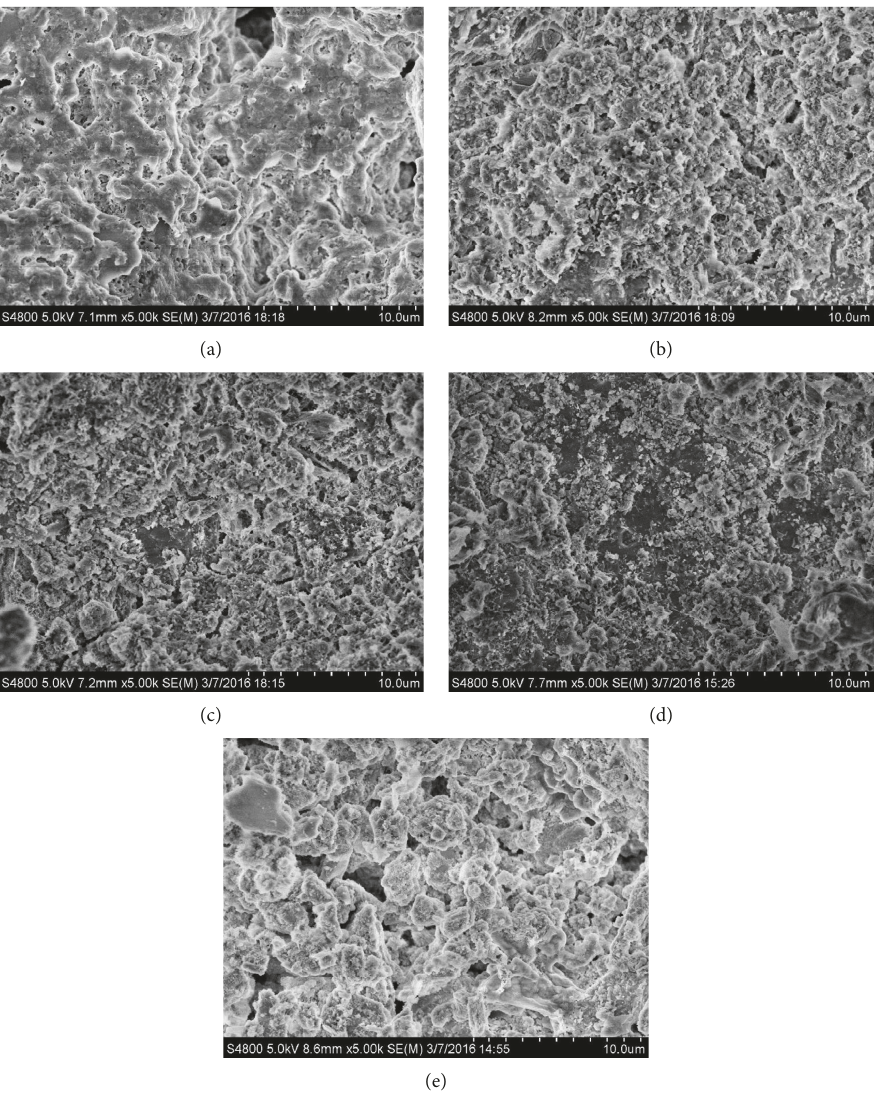
Figure 17: SEM of the solidified cement slurry test blocks. Polymer content: (a) 0%, (b) 2.5%, (c) 5%, (d) 7.5%, and (e)